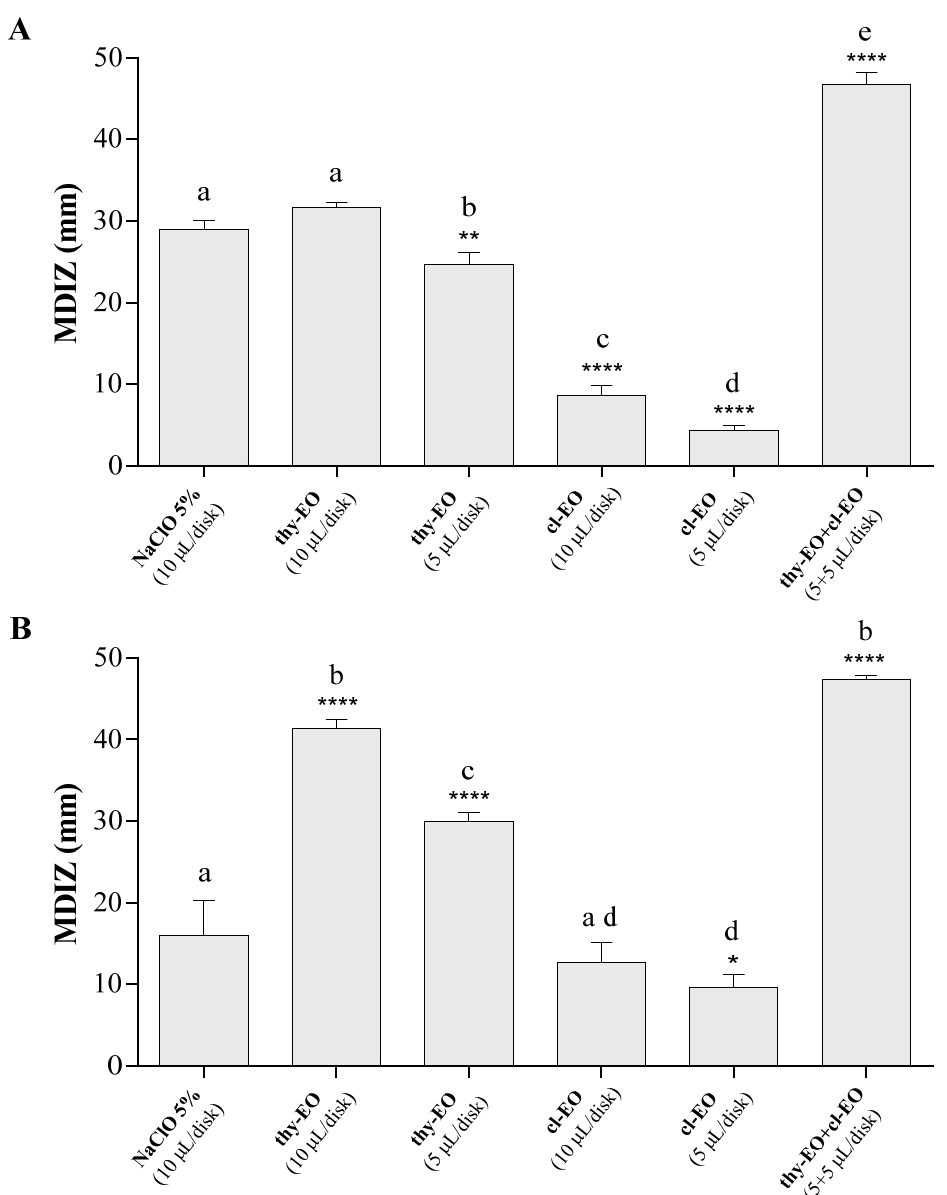
Figure 2. In vitro antibacterial activity of the volatile components of thyme and cloves essential oils, individually used and in binary combination (1:1 ratio), evaluated by the disk volatilization method, against Escherichia coli ( A ) and Staphylococcus aureus ( B ) food isolates. Graphical representation of the results; the mean diameter of inhibition zone (in mm) is reported as the mean of values obtained from assays in triplicate ± standard deviation. Statistical significance was examined by the one-way ANOVA test, with Dunnett’s correction ( p < 0.05), for bars comparison with positive control bar, and with Tukey’s correction ( p < 0.05), for multiple comparisons between bars. Asterisks indicate the statistical significance with respect to the positive control (**** p < 0.0001; ** p < 0.01; * p < 0.05); the absence of asterisks indicates absence of significance. Letters (a, b, c, d, e) are used for multiple comparisons. Different letters indicate significant differences between bars; bars with no significant differences receive the same letter. MDIZ, mean diameter of the inhibition zone; thy-EO, thyme essential oil; cl-EO, cloves essential oil; NaClO, sodium hypochlorite